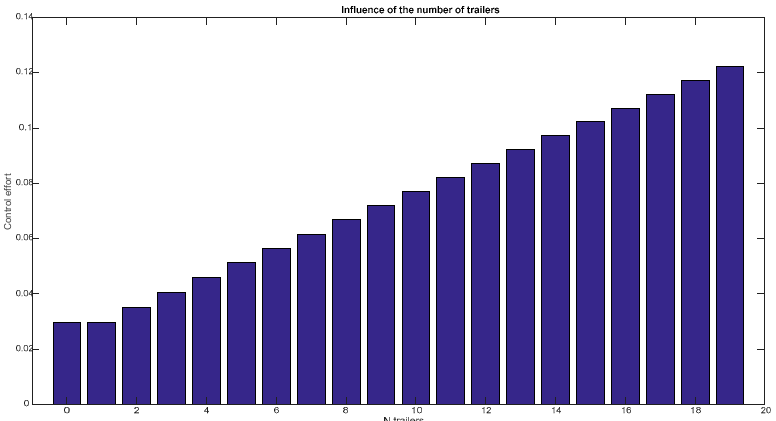
Figure 27. Influence of the number of trailers in the control effort.